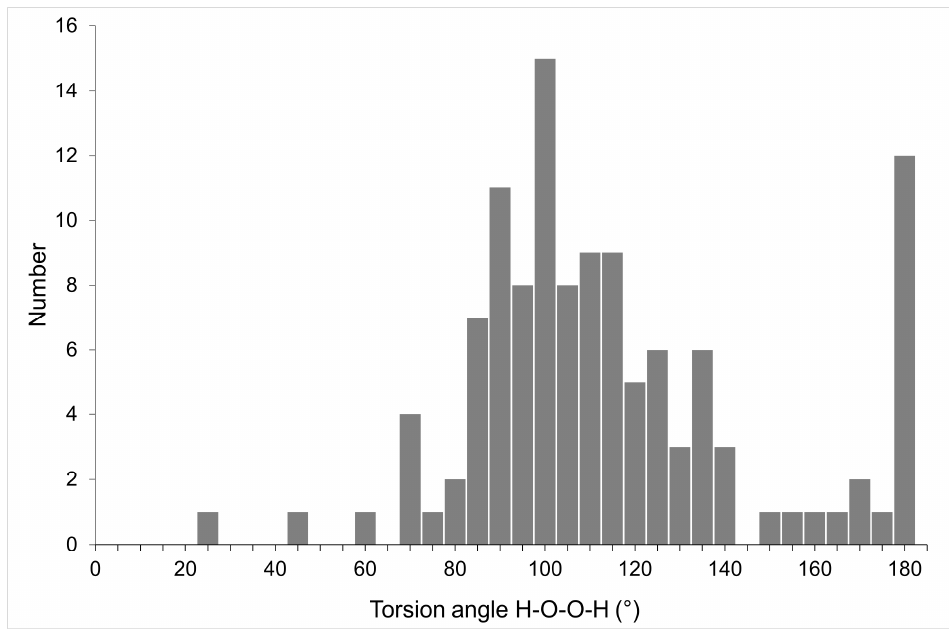
Figure 9. Distribution of H-O-O-H torsion angles in crystalline